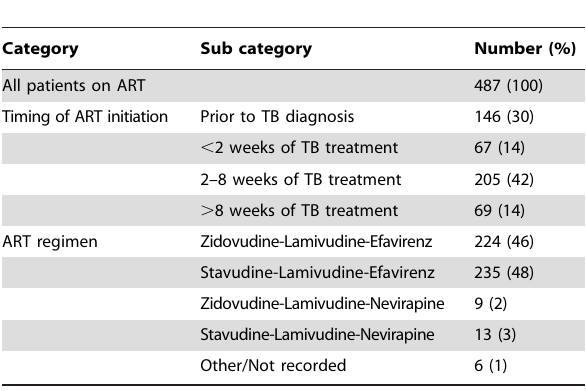
Table 2. Timing of ART initiation and ART regimen in HIV- infected TB patients registered in Karnataka state, India, in June